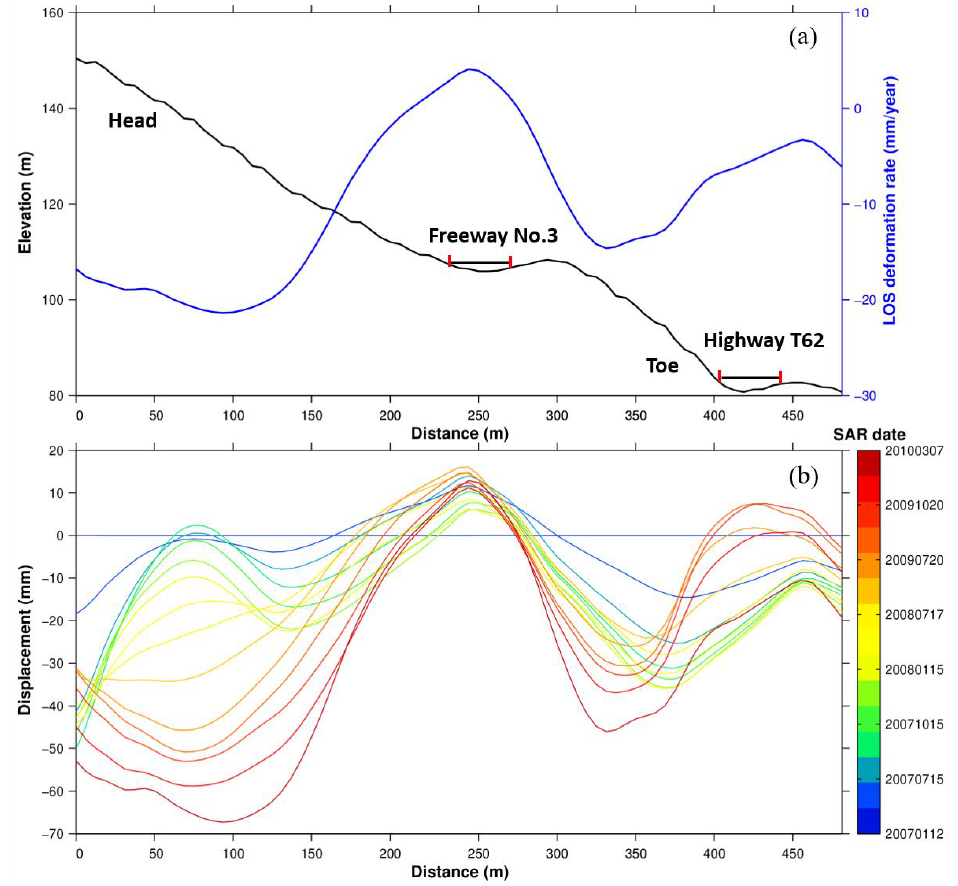
Figure 10. Profile of the landslide displacement along the artificial side slope. ( a ) Profile of elevation and mean LOS deformation velocity. ( b ) Profile of time-series displacement. The location of the profile is indicated in Figure